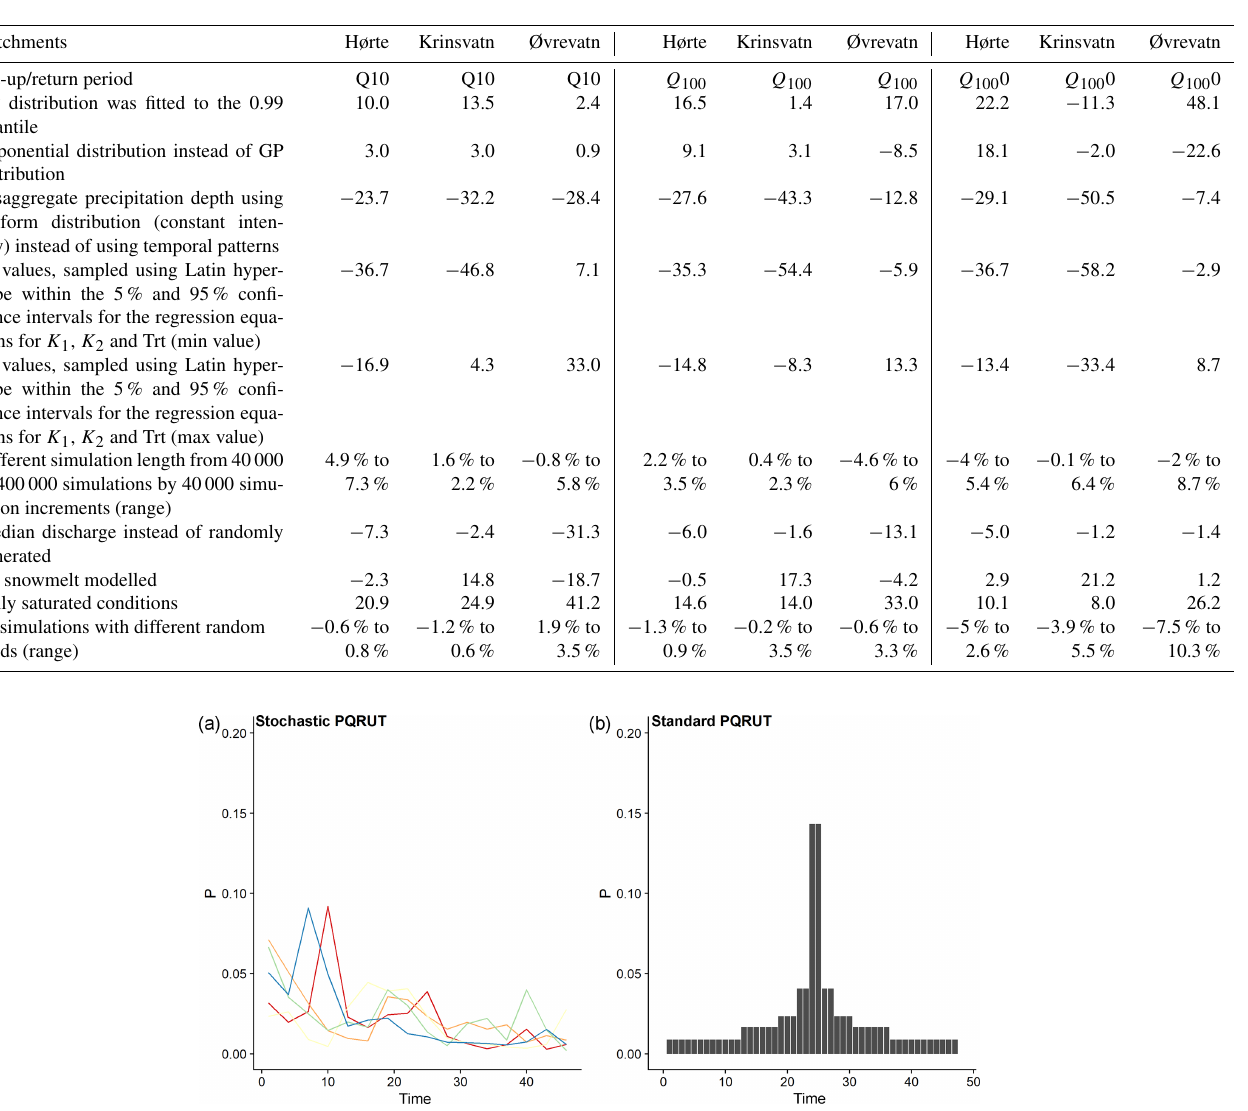
Figure 9. An example of storm patterns (only five are shown here) used for the simulated events in the stochastic PQRUT model (a) and the storm pattern typically used with the standard PQRUT model (b) . P represents the ratio of the hourly precipitation to the total precipitation depth for the